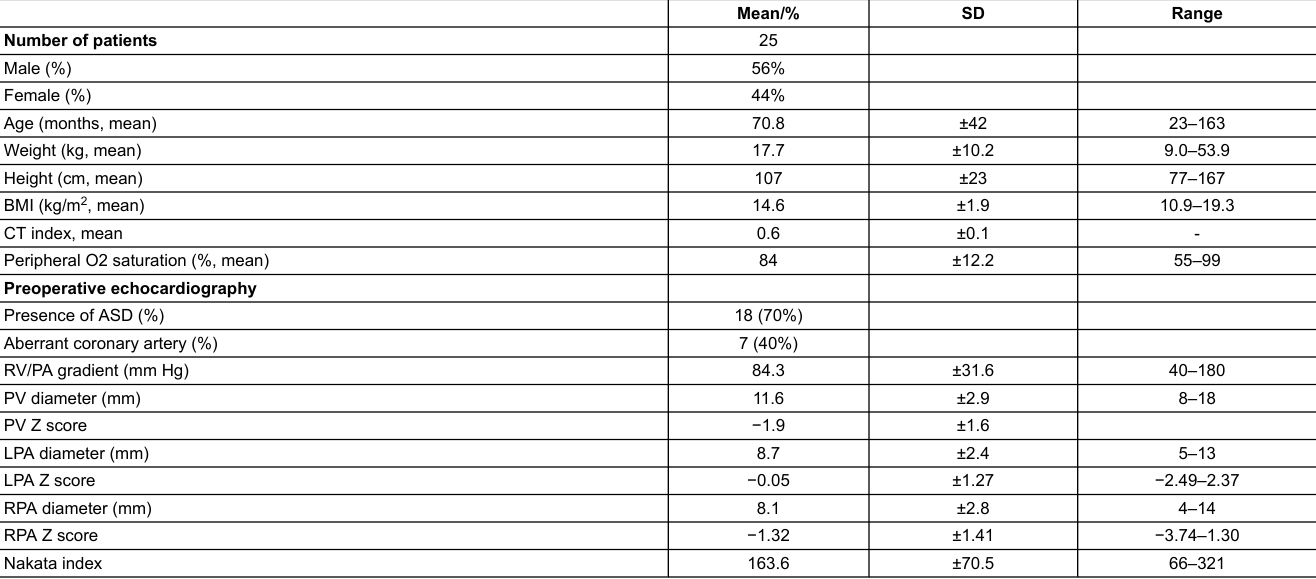
Table 1: Preoperative demographics. Number of patients